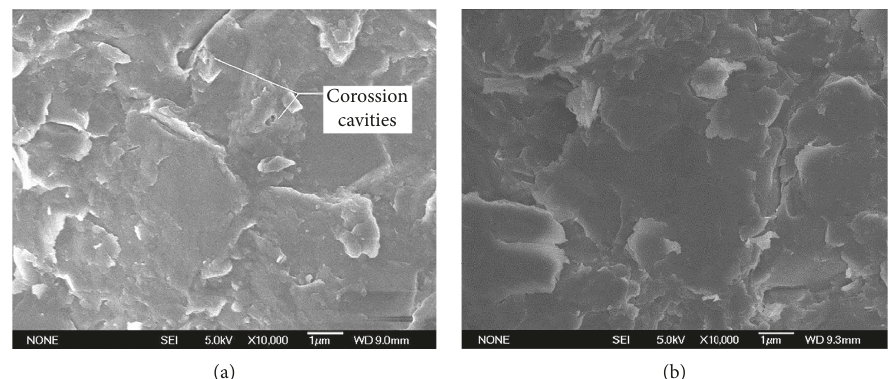
Figure 7: Micrographs of shale under the hydrochemical environment for 15 days. (a) pH � 4. (b) pH � 7.